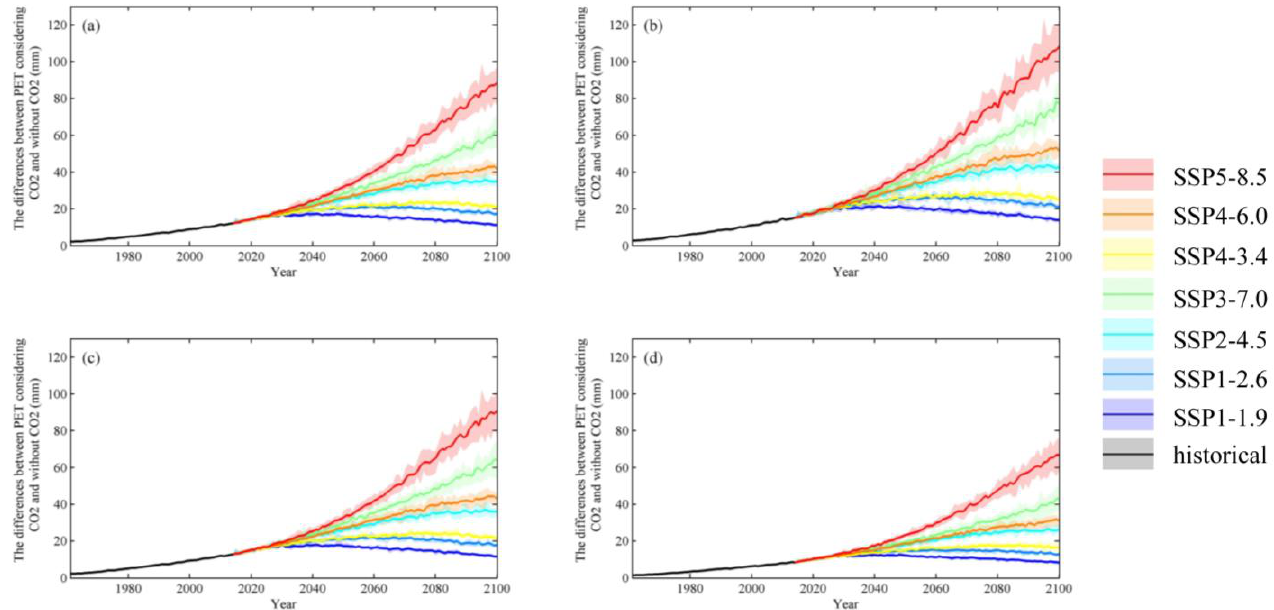
Figure 5. The differences between PET estimations with and without the CO 2 effect for 1961 – 2100: China ( a ); the arid region ( b ); the semi-arid and semi-humid region ( c ); and the humid region ( d ).